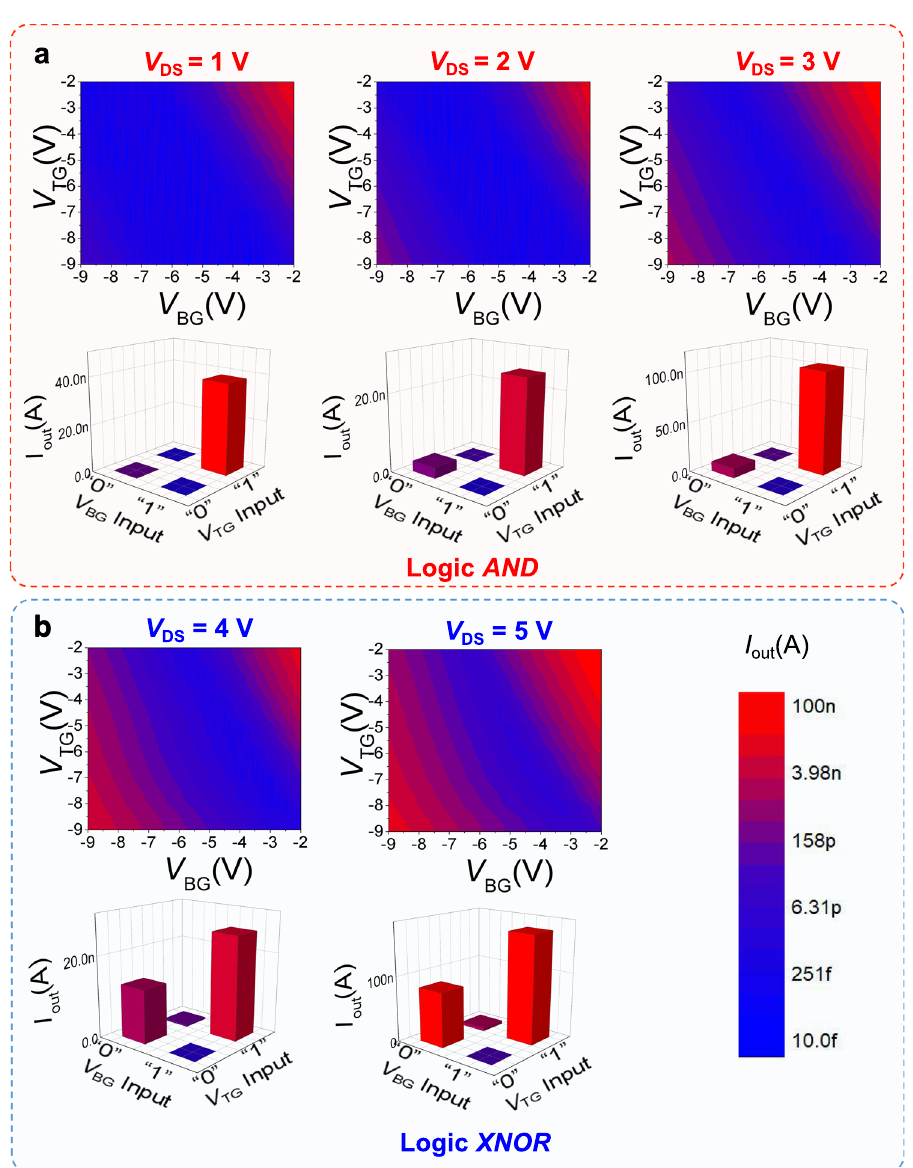
Fig. 3 The logic computing behaviours of single processing pixel. Drain current I out is mapped as a function of V TG and V BG under different Op-instruction of V DS from 1 V to 5 V. Taking − 2 V and − 9 V as input “ 1 ” and “ 0 ” of V TG and V BG , the logic behaviours are shown by the current bar of I out . At low operating voltages (1 V) of Op-instruction, a single processing pixel realises AND logic, while at high operating voltages (5 V), XNOR logic is implemented. a The output current and logic behaviours under V DS from 1 V to 3 V, devices show logic AND . b The output current and logic behaviours under V DS from 4 V to 5 V, devices show logic XNOR